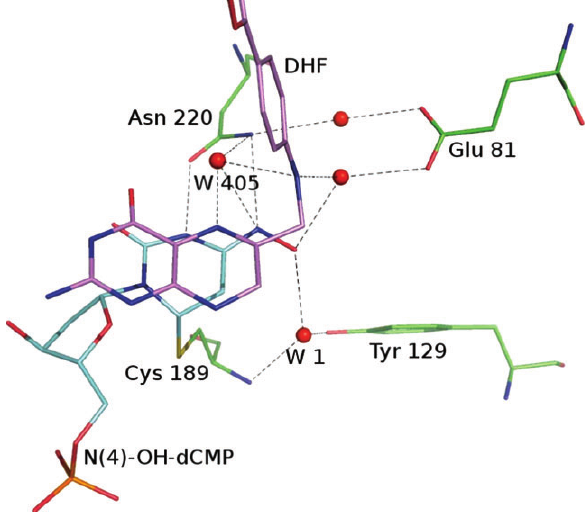
Figure 6 Hydrogen bonding network in mTS-N 4 -OH-dCMP-DHF con- necting the ligands (N 4 -OH-dCMP and DHF) with nearby amino acids (Asn 220, Glu 81 and Tyr 129) through ordered water molecules (including W 405 and W